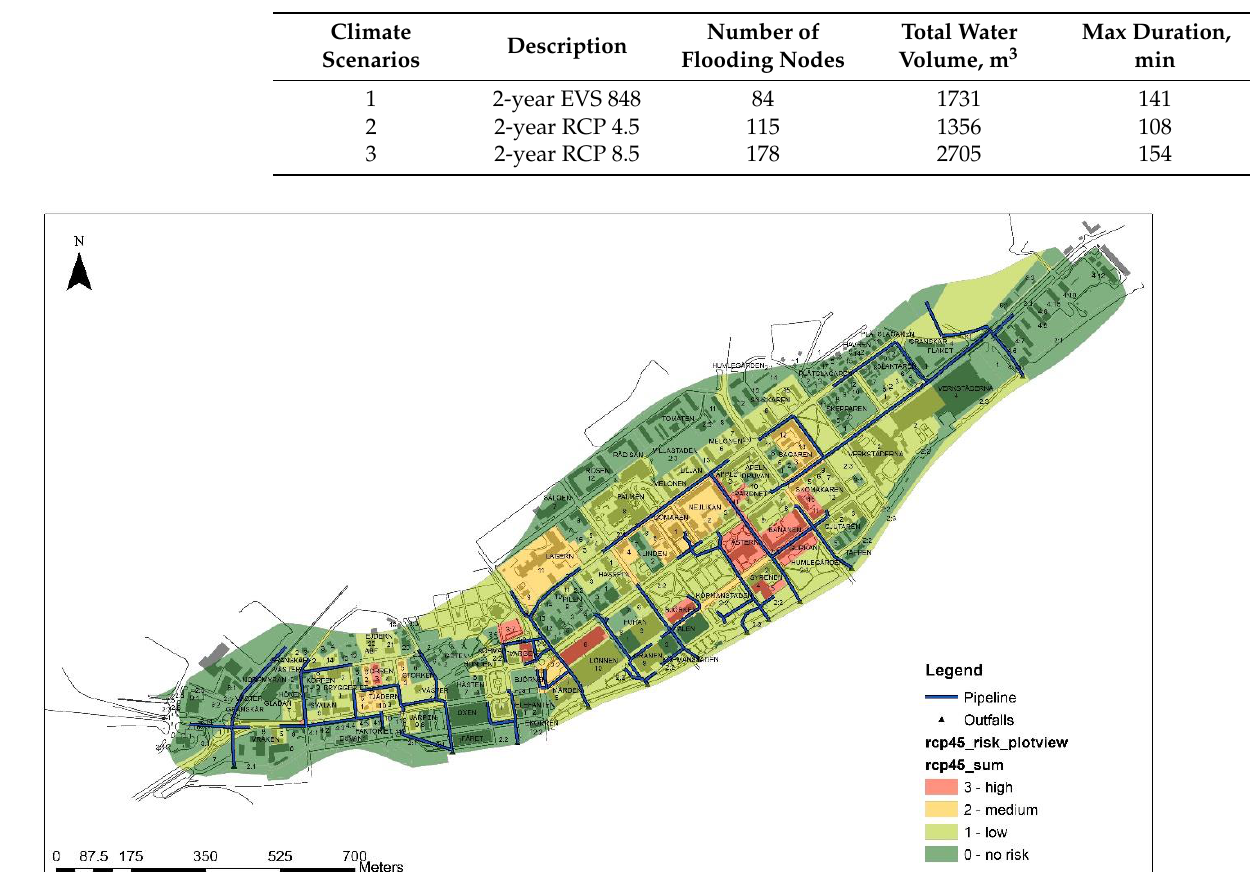
Table 5. Flooding indicators for different scenarios in Söderhamn.